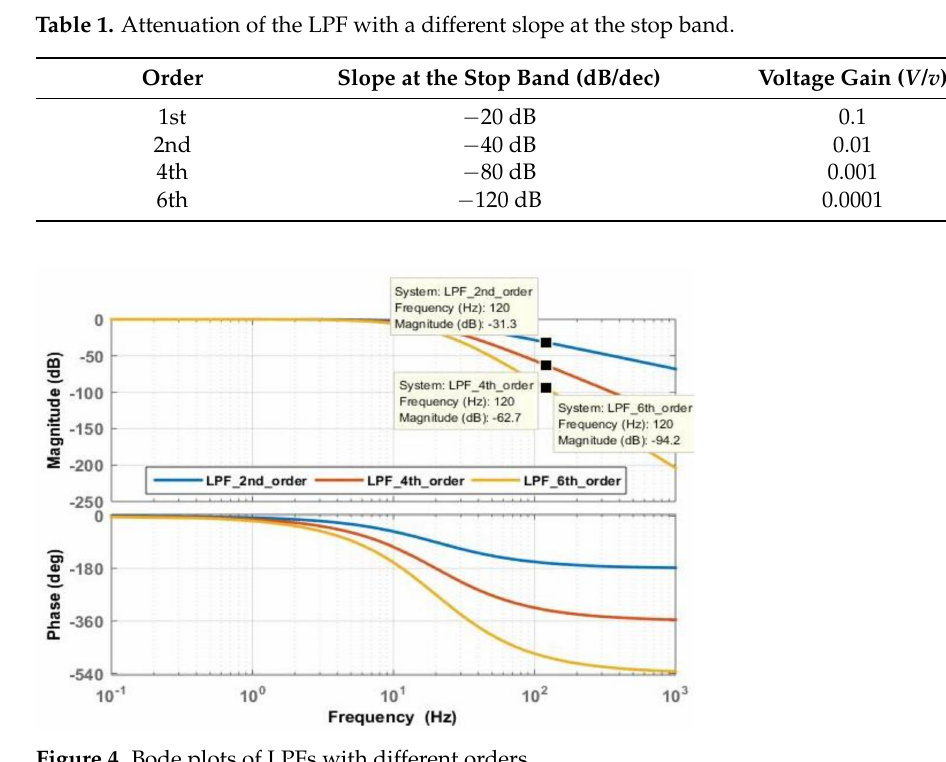
Figure 4. Bode plots of LPFs with different